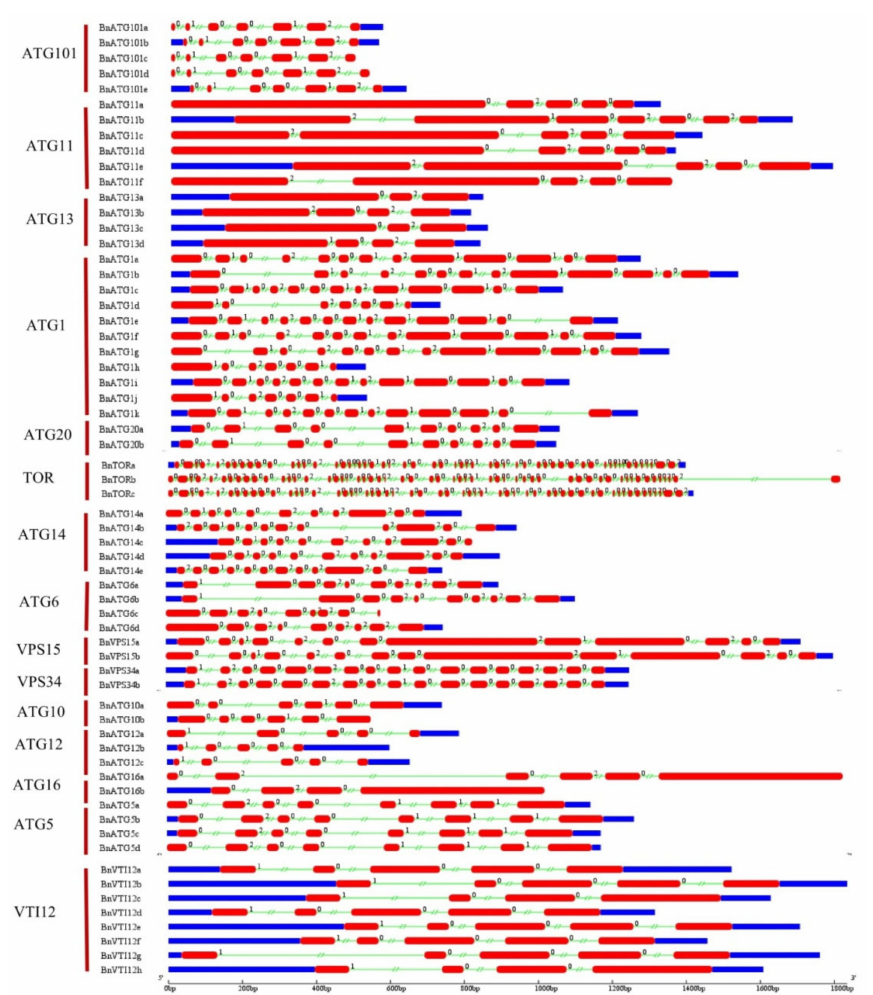
Figure 4. The exon–intron structure of ATG1, ATG5–6, ATG10–14, ATG16 , and ATG18 in B. napus . Exons and introns were represented by red boxes and green lines, respectively. The exon–intron structure of the BnATGs was determined using a gene structure display server